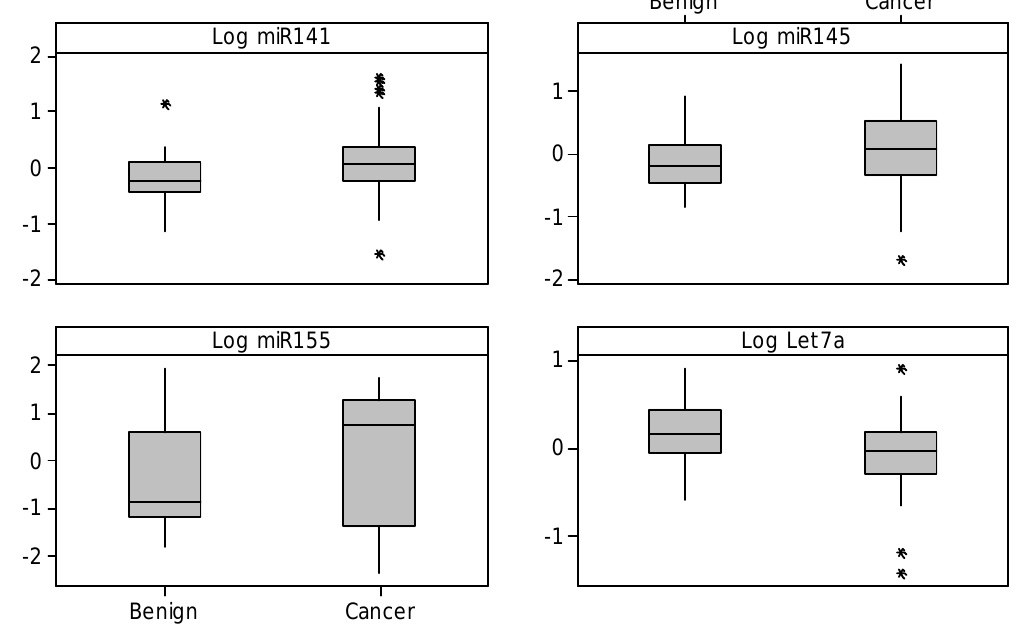
Figure 1. Boxplots of the four dysregulated